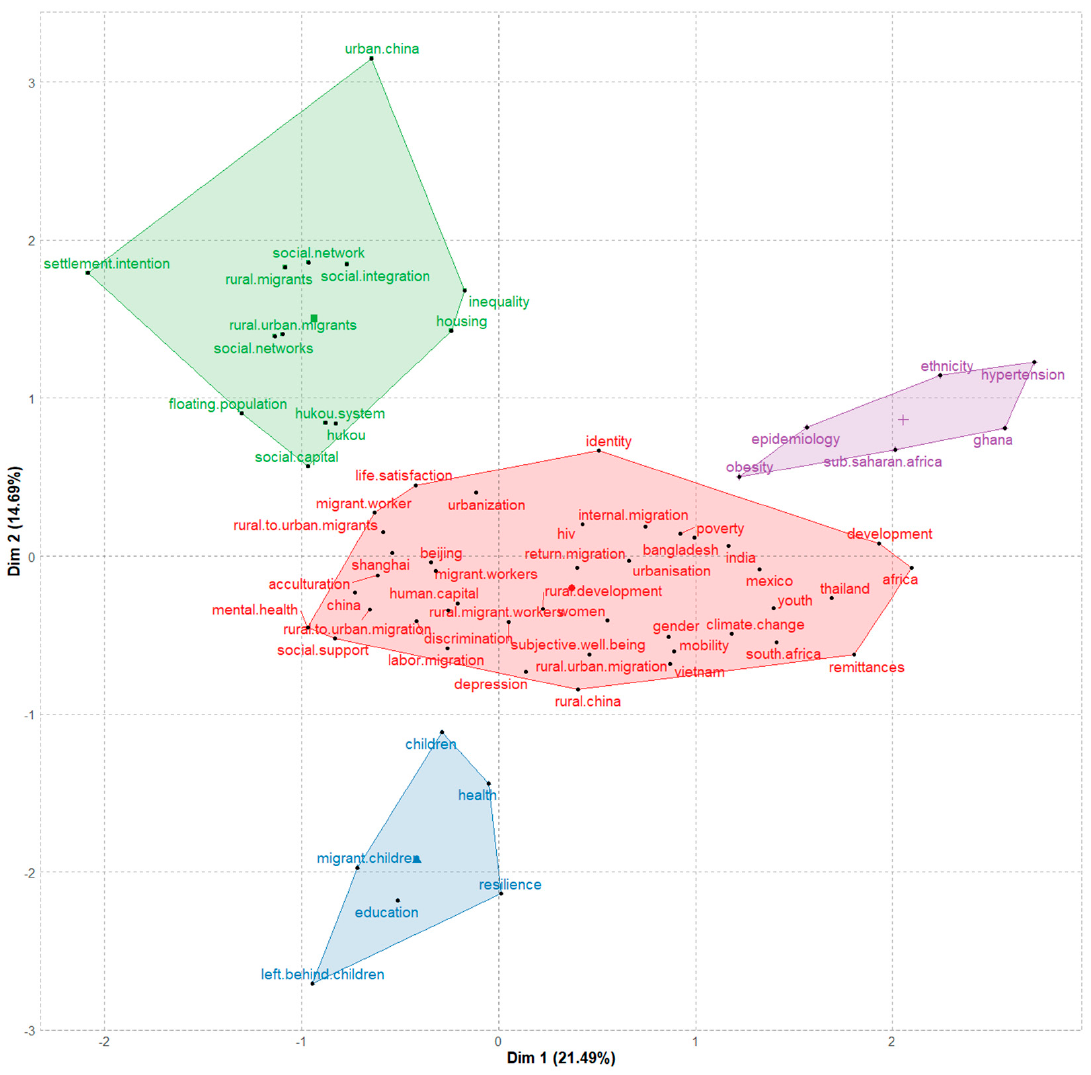
Figure 10. Conceptual structure map of rural-to-urban migrant studies (1 January 2004–3 June 2022). Green cluster: China’s Hukou system and its institutional impact. Attention was